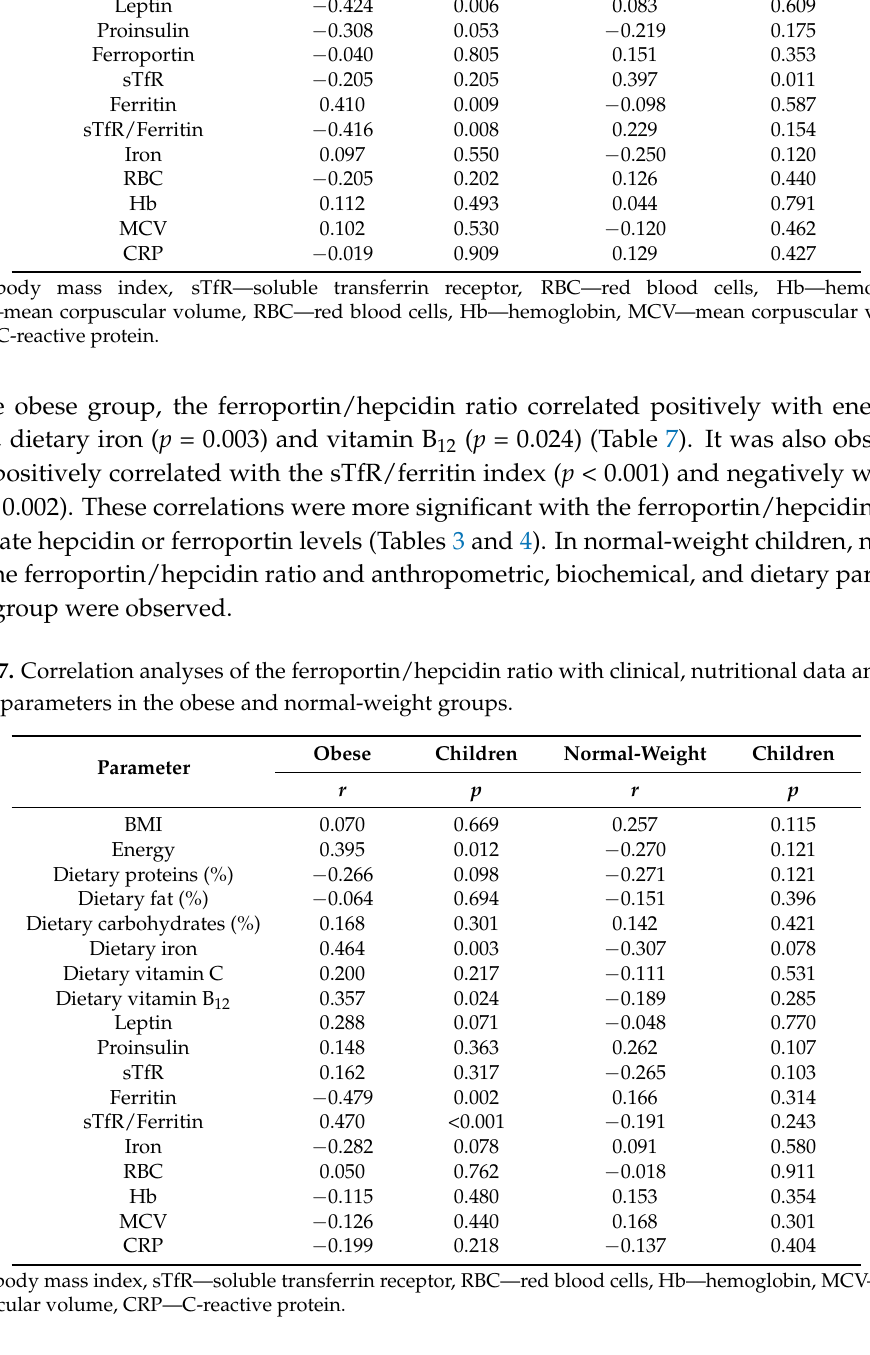
Table 6. Correlation analyses of hepcidin with clinical, nutritional data and iron status parameters in the obese and normal-weight groups. Obese Children Normal-Weight Parameter